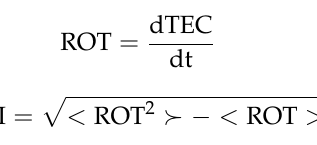
Figure 5. Monthly TEC variation over the BOWEN CASES GPS during 2021. The monthly TEC from the GPS data, as described in the methodology, has been computed for all months in 2021, a low-solar-activity year. These monthly observations are shown in Figure 5 from January to November 2021. The right-handed bar shows the intensity of the monthly TEC. The monthly TEC is characterized by a minimum in magnitude at pre-sunrise (04:00 LT–06:00 LT, ~4 TECU–~5 TECU), maximum in magnitude at daytime (11:00 LT–15:00 LT, ~30 TECU–~50 TECU), decrease in magnitude at post-sunset (17:00 LT–20:00 LT, (~25 TECU–~35 TECU), and a further decrease at nighttime (20:00 LT–24:00 LT, ~7 TECU–~15 TECU). Our observations agree with the previous investigations of [1,22–27]. They reported the weakest TEC during the pre-sunrise hours. Around the equatorial station, they